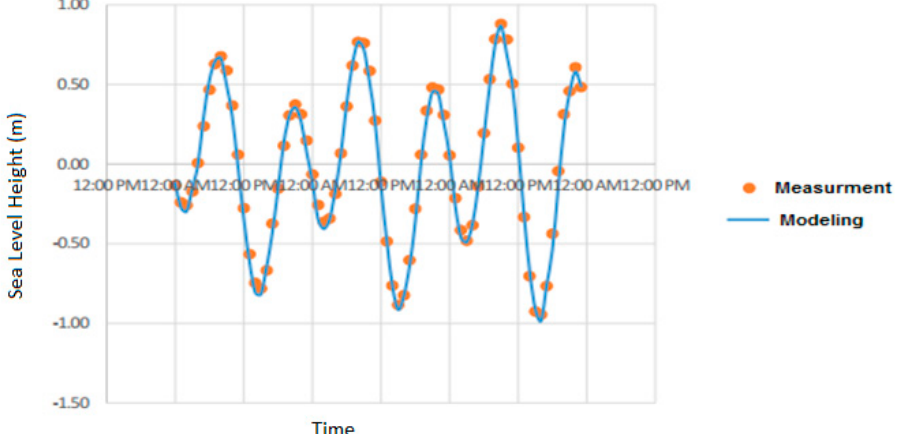
Figure 6. Delft3D modelled and measured water level.